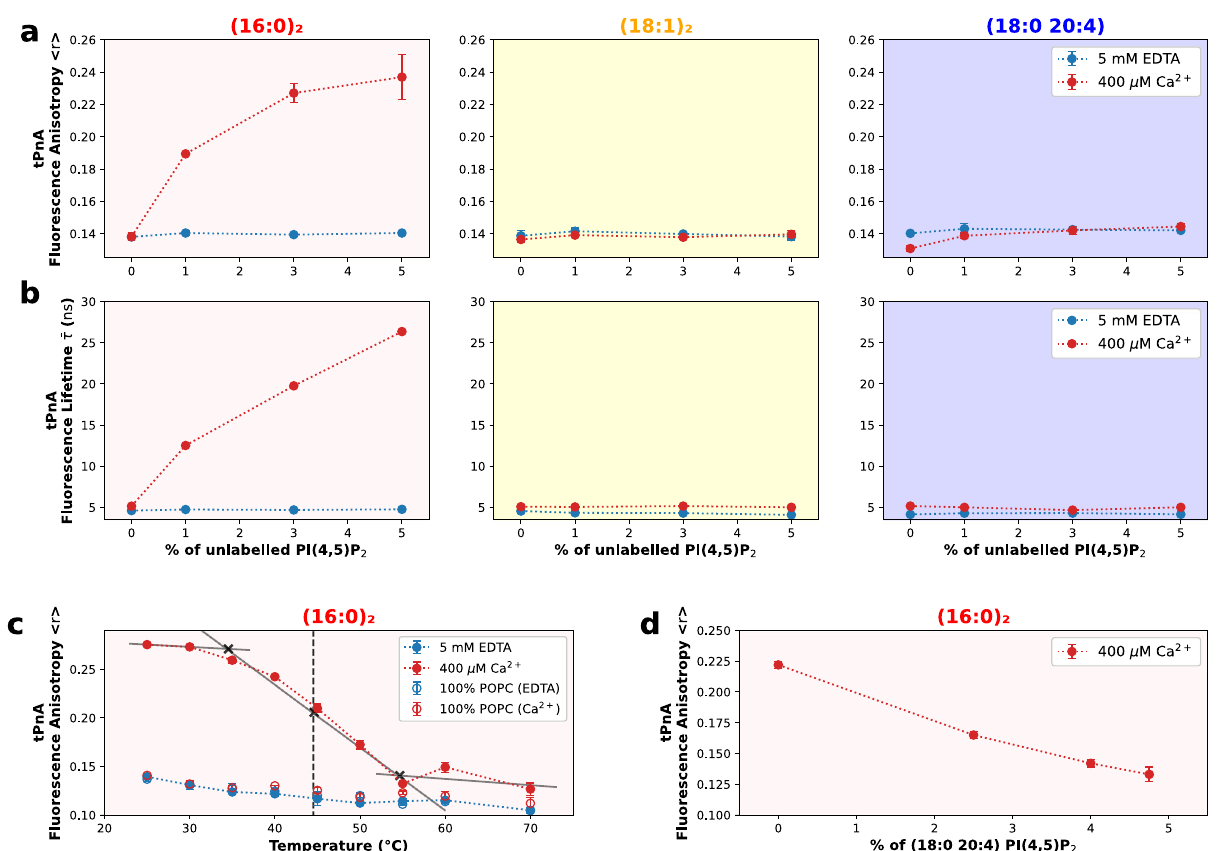
Fig. 4 (16:0) 2 PI(4,5)P 2 forms gel-like nanodomains upon undergoing calcium-induced clustering. PI(4,5)P 2 gel-like properties were detected through the incorporation of tPnA at a 1:300 lipid ratio in MLVs containing POPC and increasing concentrations of unlabeled PI(4,5)P 2 . Experiments were done for the three acyl-chain compositions in study. tPnA fl uorescence anisotropy ( a ) and fl uorescence intensity weighed lifetime ( τ ) ( b ) were measured in the presence (400 µ M Ca 2 + , red) and absence (5 mM EDTA, blue) of calcium. In the presence of calcium, we observed no effect on tPnA fl uorescence lifetime for both (18:1)2 PI(4,5)P 2 (F(1,12) = 1.564, p = 0.2349) and (18:0 20:4) PI(4,5)P 2 (F(1,12) = 0.7426, p = 0.4057). For (16:0)2 PI(4,5)P 2 in the presence of calcium, we observe a steep increase in both fl uorescence anisotropy and fl uorescence lifetime (F(1,12) = 708.1, p ≤ 0.0001). The thermal pro fi le of tPnA anisotropy ( c ) was measured in samples composed of POPC:PI(4,5)P 2 90:10. Controls were also carried out with samples of pure POPC. The impact of increasing concentrations of (18:0 20:4) PI(4,5)P 2 on the formation of (16:0) 2 PI(4,5)P 2 gel-like nanodomains ( d ) was detected in MLVs, containing POPC: PI(4,5)P 2 (95:5) at several (16:0) 2 to (18:0 20:4) PI(4,5)P 2 ratios, through the incorporation of tPnA at a 1:300 lipid ratio. Error bars for fl uorescence anisotropy measurements represent the SD from N = 3 independent